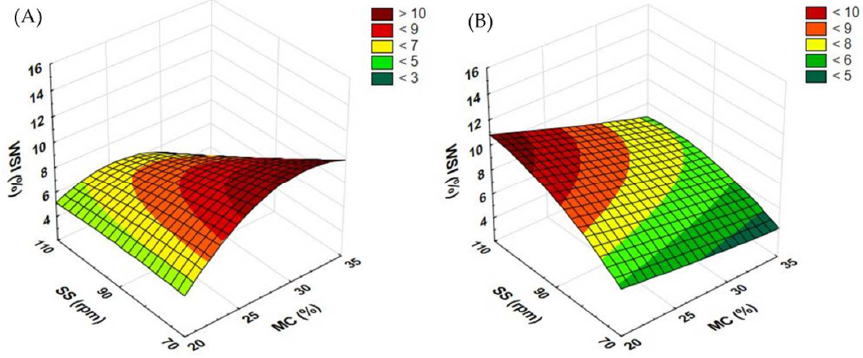
Figure 10. Results of the WSI of extrudates obtained from rapeseed straw ( A ) and buckwheat straw ( B ) before modification of the plasticizing system: MC—moisture content; SS—screw speed; WSI—water solubility index.